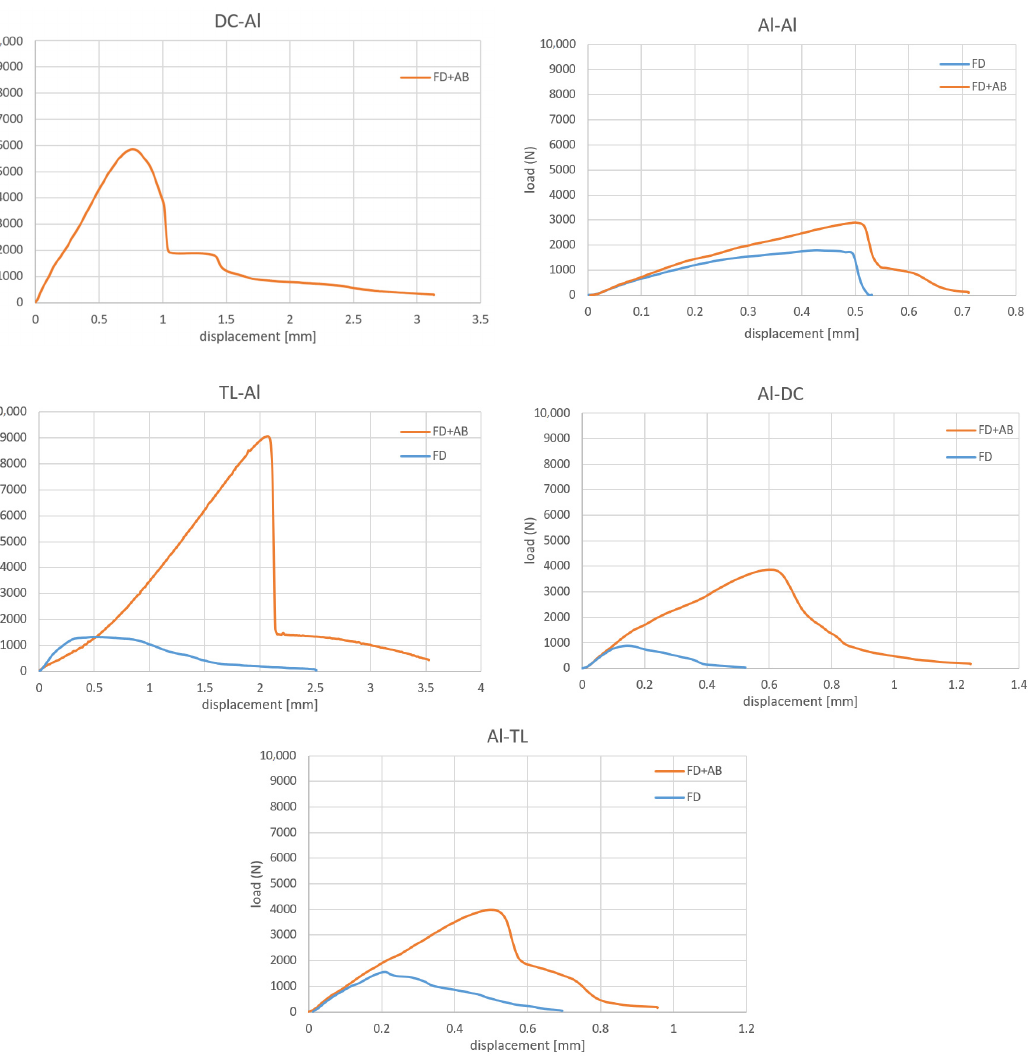
Figure 14. Comparison of loading curves of flowdrill joints (FD) and joints combined with adhesive bonding (FD + AB).